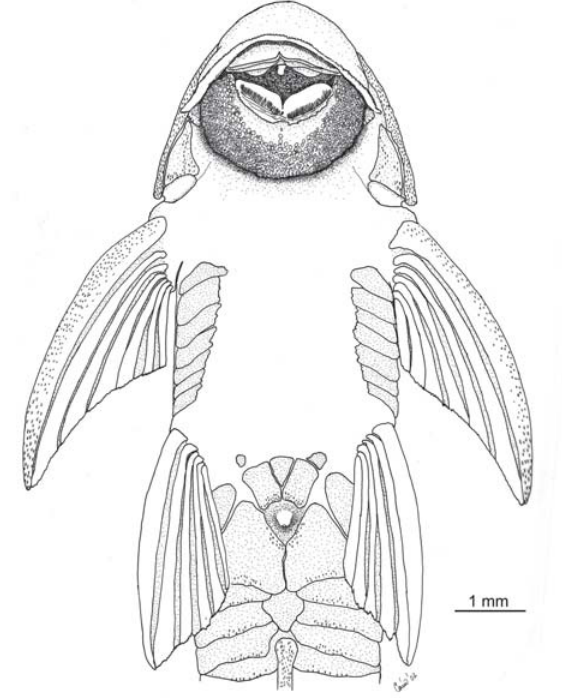
Fig. 2. Harttia merevari , MBUCV-V-26578, holotype, 99.4 mm SL. Ventral region showing the shape, relative size and/or arrangement of bony plates in front of the gill opening, be- tween pectoral and pelvic fins, and preanal area.